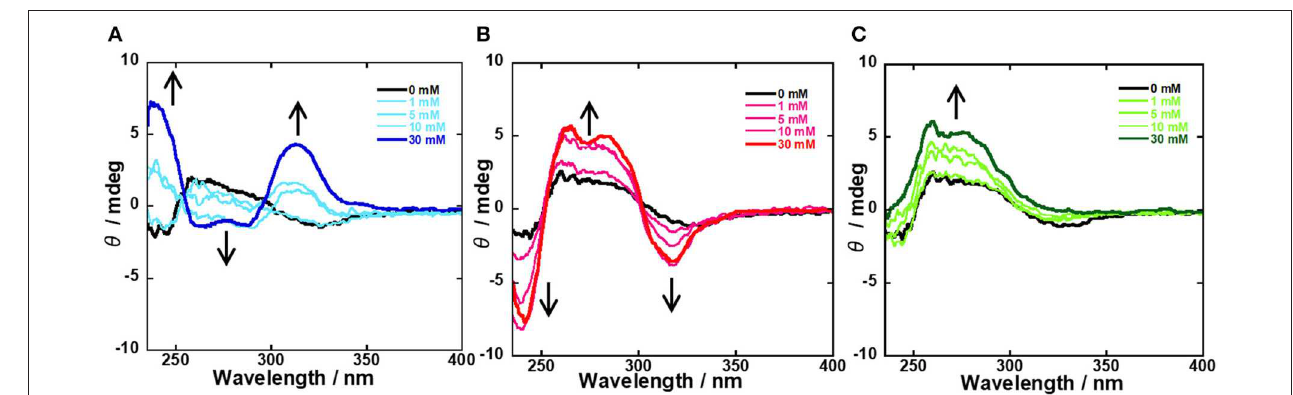
FIGURE 7 | ICD spectral changes of 1 / γ -CyD complex in 2% DMSO − 98% water (v/v) with the addition of various concentrations of sugars [ (A) glucose, (B) galactose, (C) fructose] at pH 7.4. [ 1 ] = 10 µ M, [ γ -CyD] = 5mM, [sugar] = 0–30mM, [phosphate buffer] = 10mM, [NaCl] = 100mM.